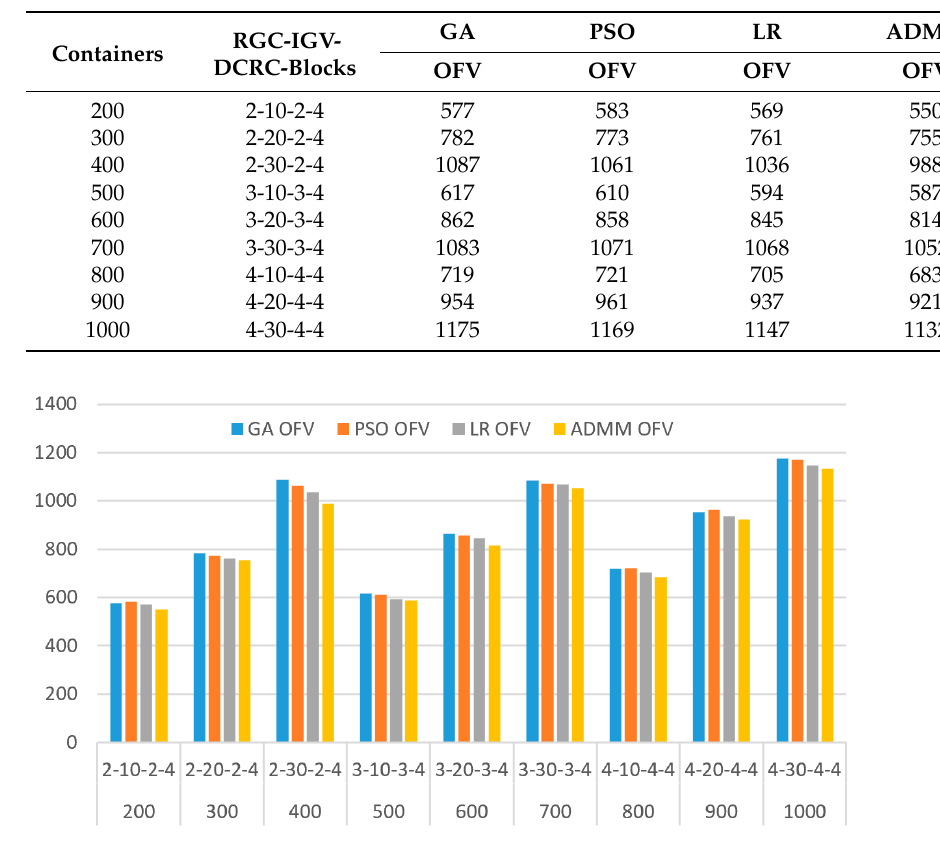
Figure 12. Performances of OFV in different algorithms.